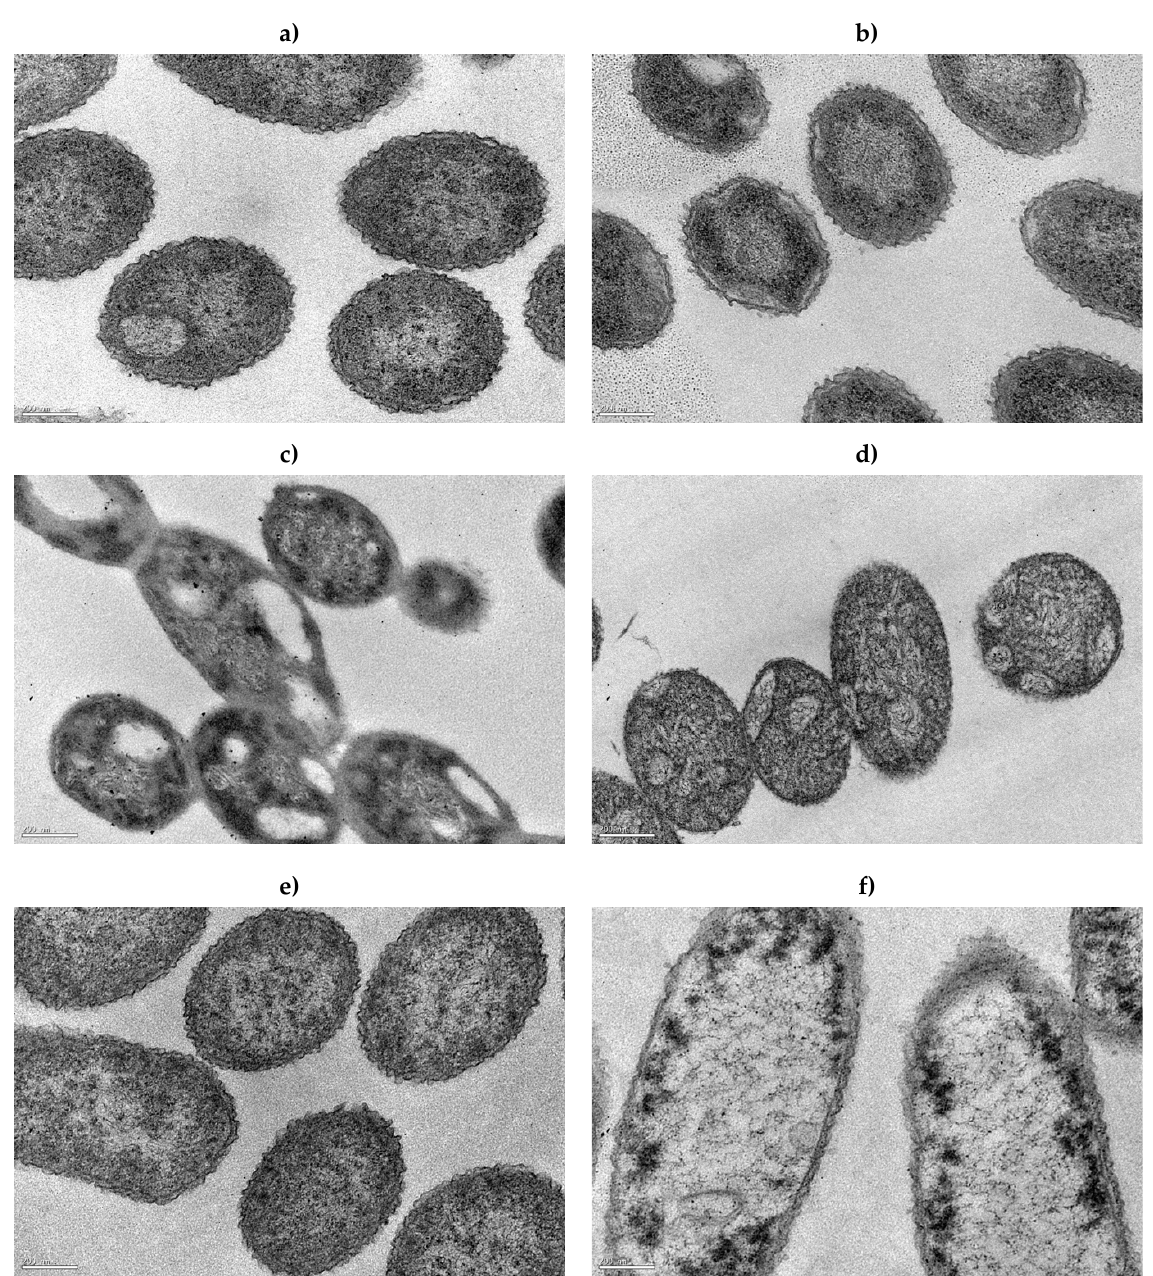
Figure 5. Transmission electron micrographs (80,000×) of P. fluorescens cells after biocide exposure ( a , c , and e ) and after an overnight step ( b , d , and f ) of ( a and b ) untreated C − ; ( c and d ) previously ( a , c , e ) and after an overnight step ( b , d , f ) of ( a , b ) untreated C − ; ( c , d ) previously exposed for 30 min to exposed for 30 min to BAC MBC (100 mg/L); and ( e and f ) previously exposed to DBNPA MBC (10 BAC MBC (100 mg/L); and ( e , f ) previously exposed to DBNPA MBC (10 mg/L). Scale bar = 200 nm. mg/L). Scale bar = 200 nm. TEM micrographs of untreated (C − ) P. fluorescens cells (Figure 5b) show intact